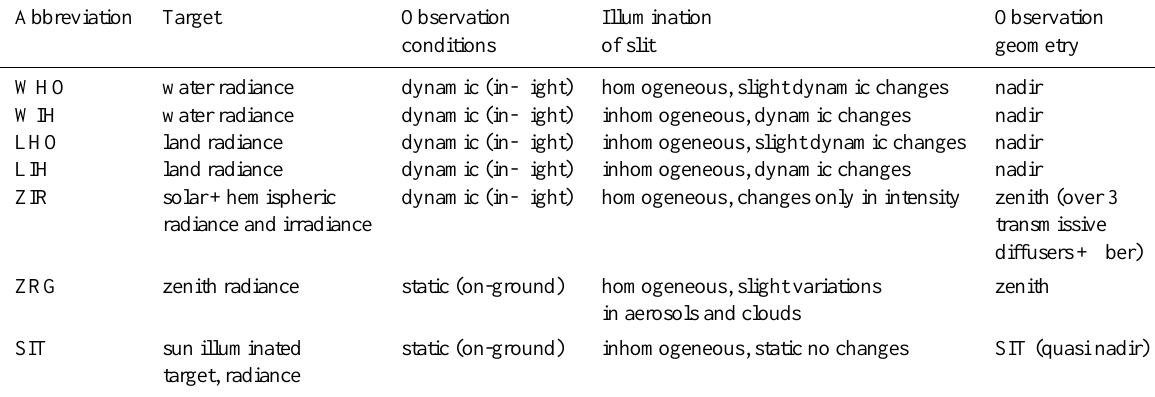
Table 5. MAMAP reference targets data set selected for precision